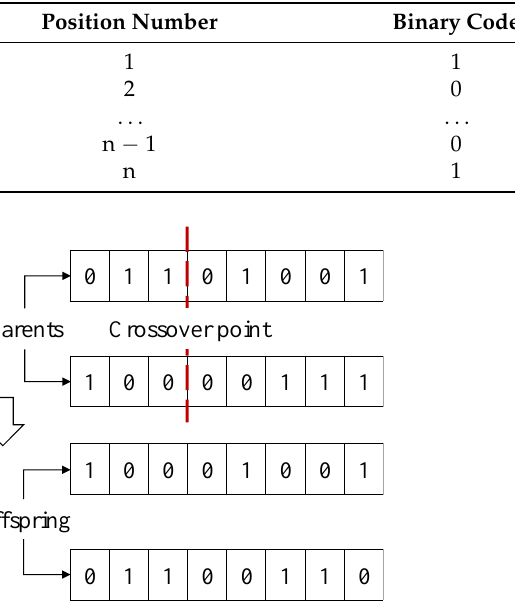
Figure 1. Example of single-point crossover.